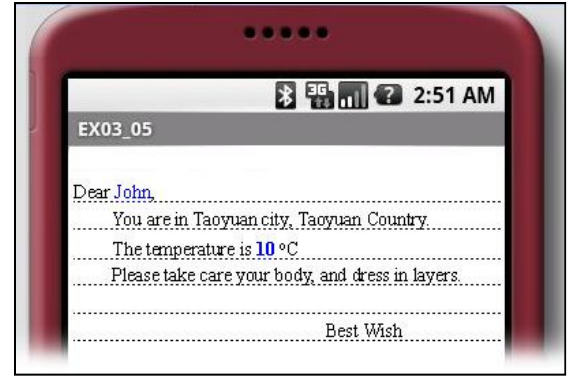
Figure 16. Example of cold wave adviser service message.